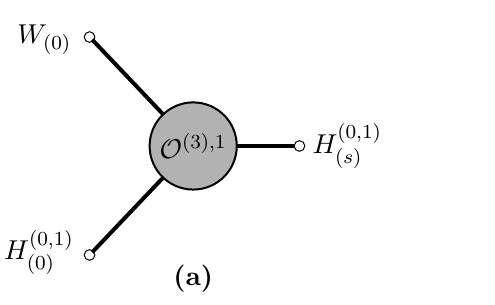
, in the form of a single H (0 ; 1) ( s ) (diagram (b) ) coupling to H (0 ; 1) (0) ( s )